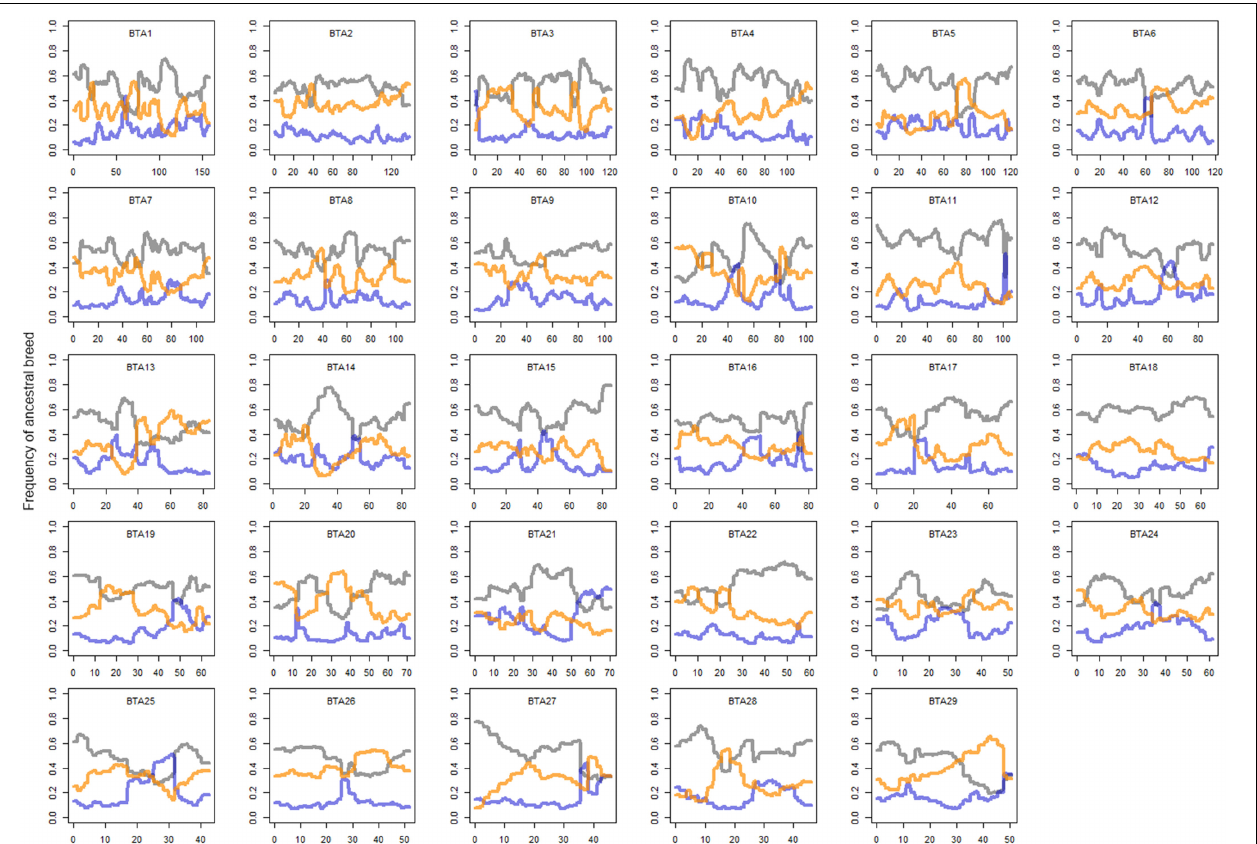
FIGURE 2 | Local ancestry of crossbreds. Gray, orange, and blue lines represent Holstein, Norwegian Red, and Guernsey, respectively. Mean local ancestry of SNP is plotted on genomic position of each chromosome. y axis is percentage ancestral breed and x axis genomic